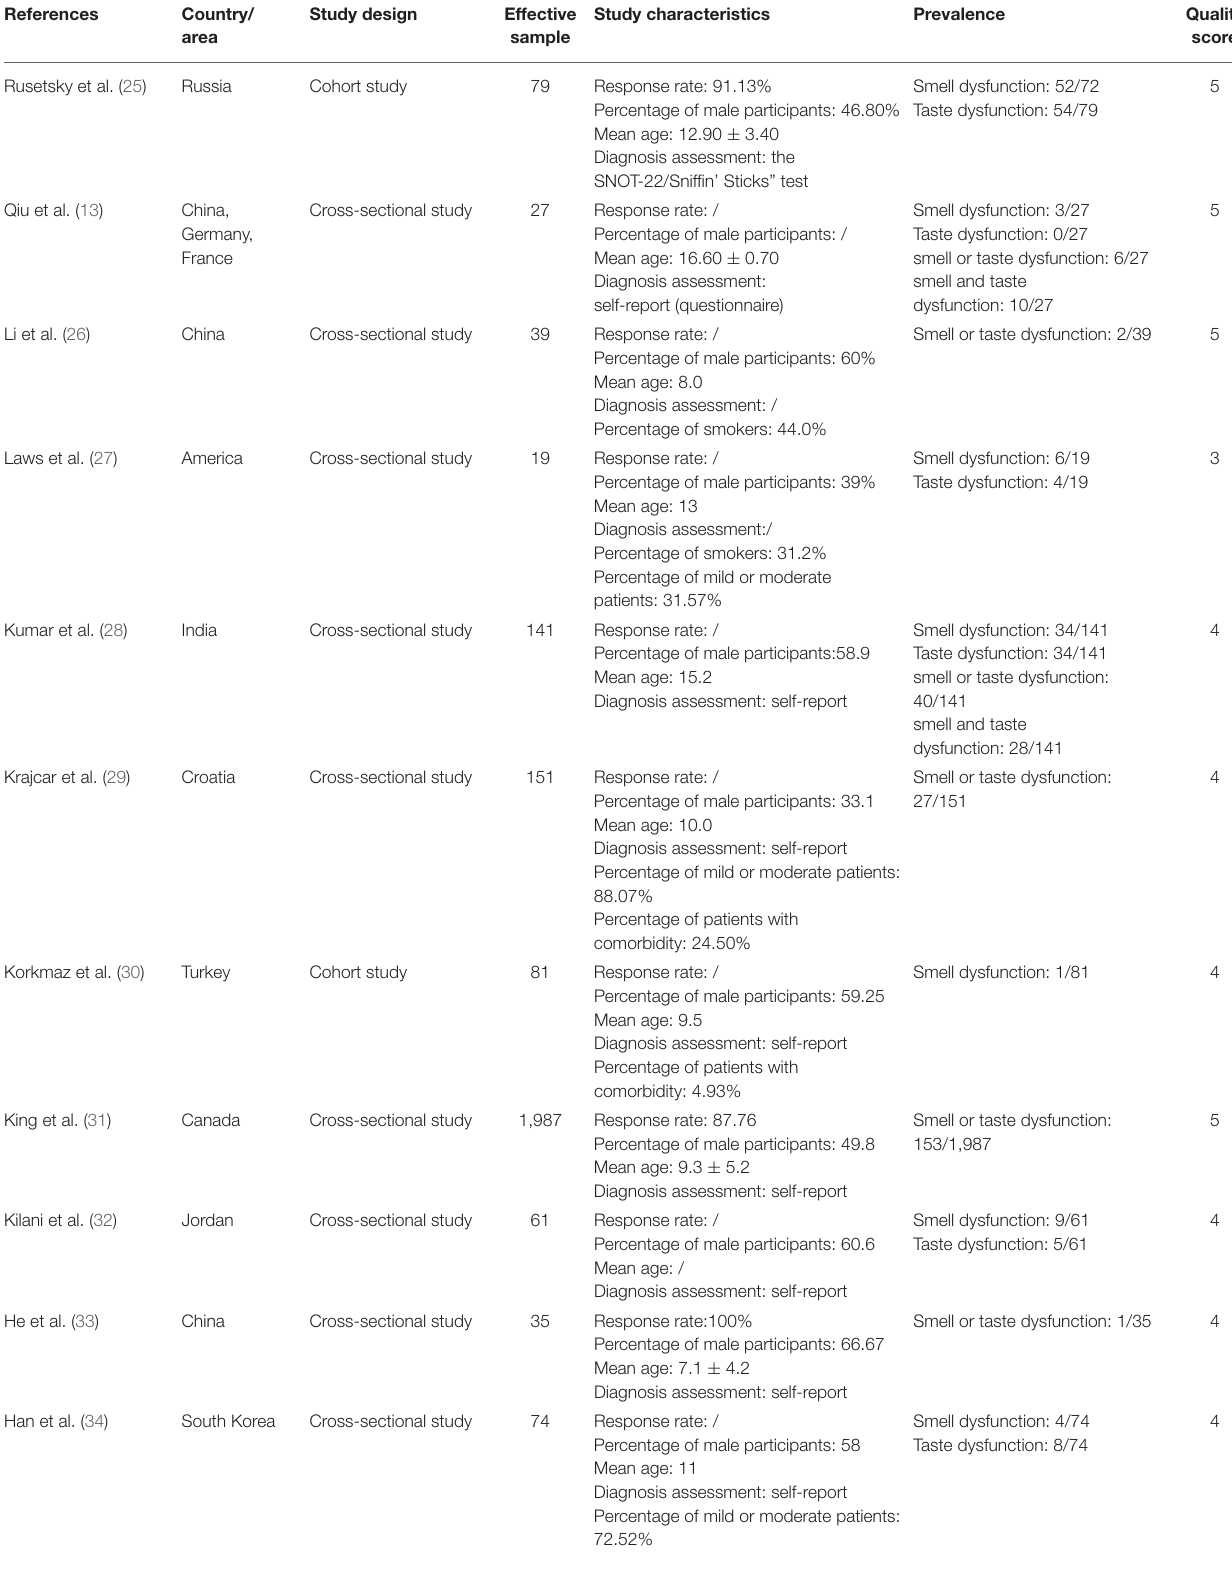
TABLE 1 | Study characteristics of included